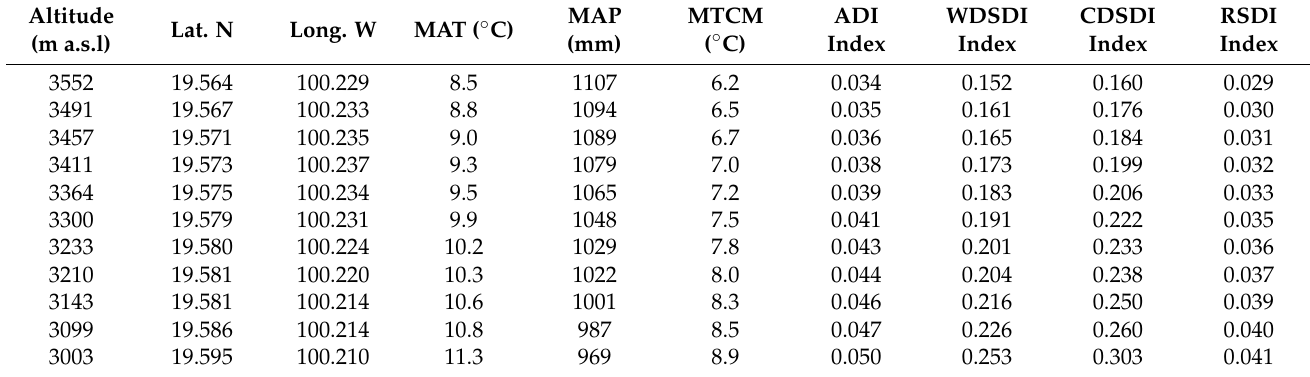
Sites at altitudes from 3552 to 3300 m a.s.l and at 3099 m a.s.l. were collected at Ejido La Mesa. Sites from 3233 to 3143 m a.s.l. were collected at Ejido Buenavista Casablanca. Site at 3003 m a.s.l. was collected at Ejido Guadalupe Buenavista, Municipality of San Jos é del Rinc ó n, Estado de M é